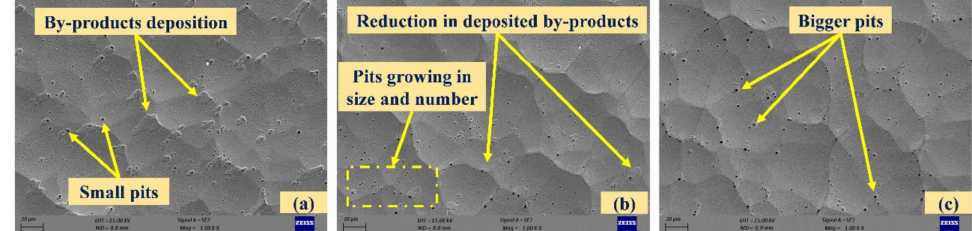
Figure 8. SEM images of chemically treated surfaces with 15% hydrogen peroxide (( a – c ): exposure times of 10, 20, and 30